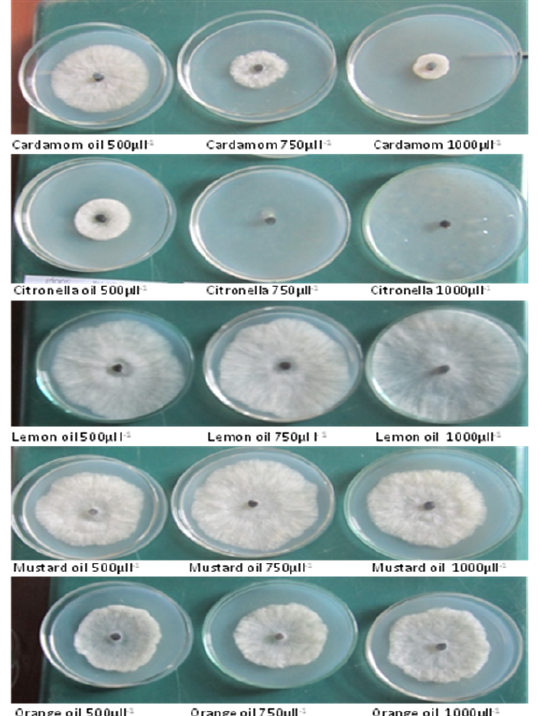
Figure 3: Mycelial growth inhibition of Lasiodiplodia sp. isolated from papaya on PDA Petri plates enriched with different essential oils, 2 days after